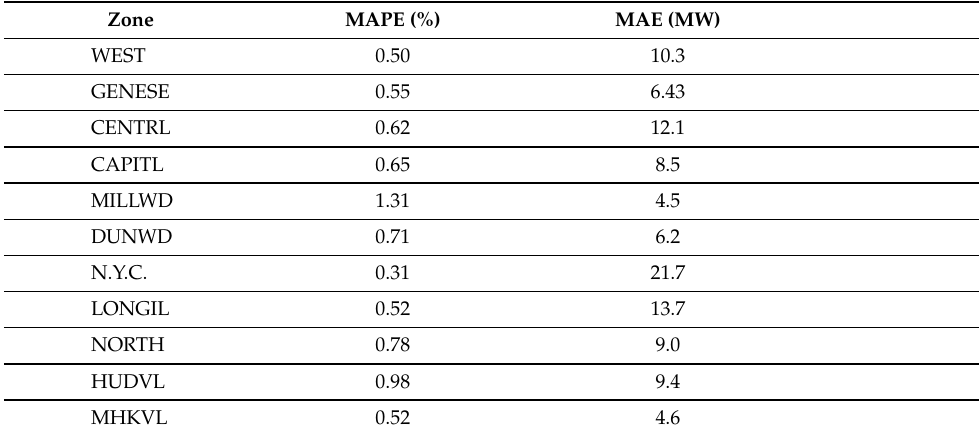
Table 3. One-hour ahead MAPE/MAE results for all NYISO zones for 2013.